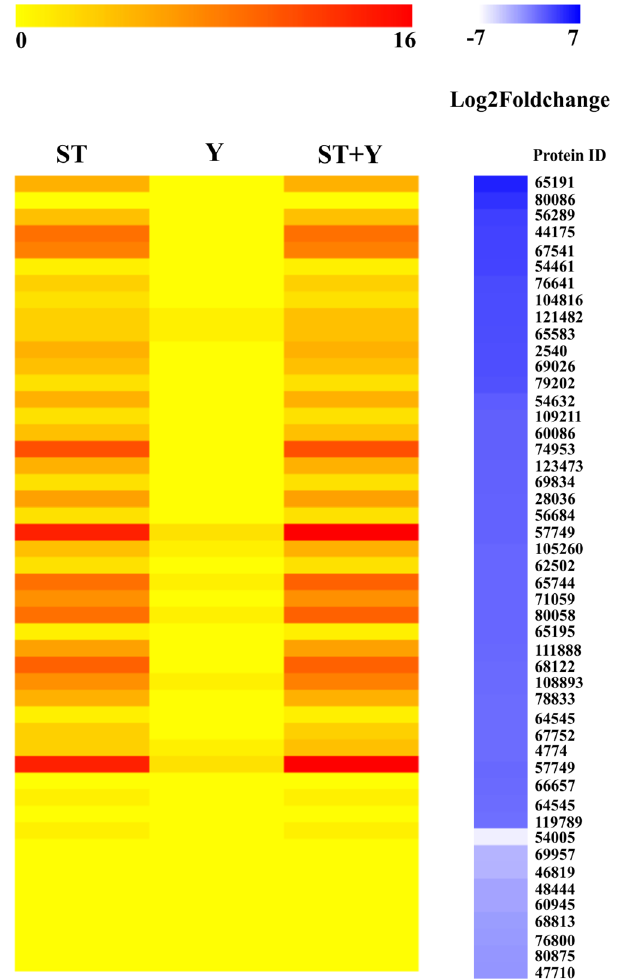
Figure 7. Heat map of predicted MAPK phosphorylation sites of MFS transporters in the Δ tmk1 and Δ tmk2 strains grown in sugarcane bagasse. ST: serine and threonine residues are phosphorylated; Y: phosphorylation occurs in tyrosine residues and ST + Y: phosphorylation sites in all three residues, serine, threonine, and